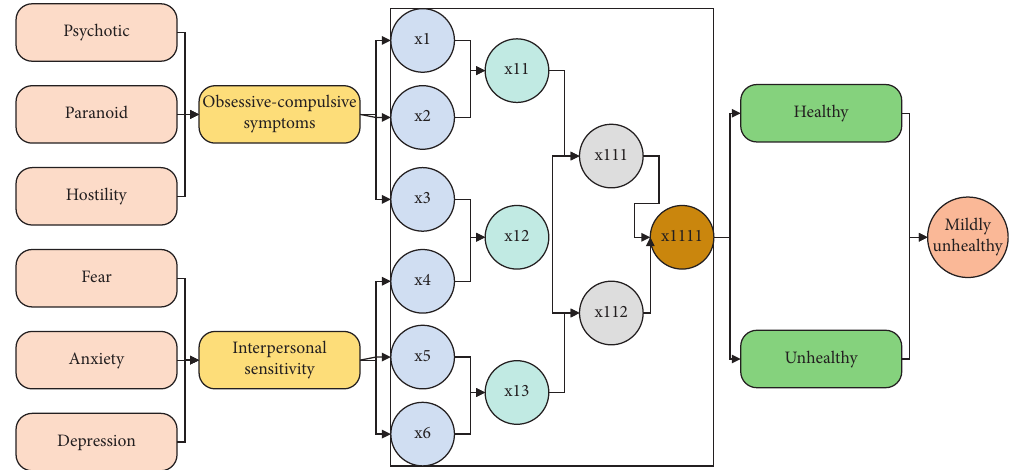
Figure 1: Mental health state evaluation